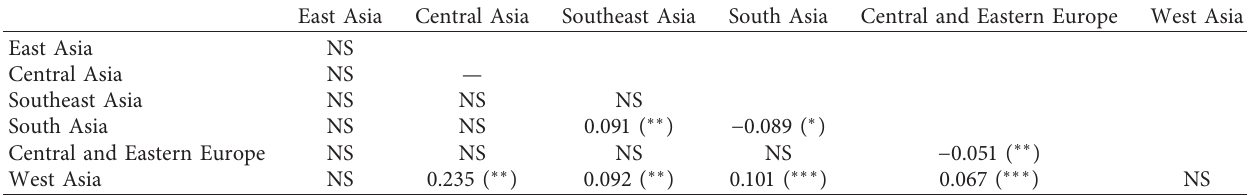
Table 7: Results of OLS regression analysis of the ED within and between subregions.